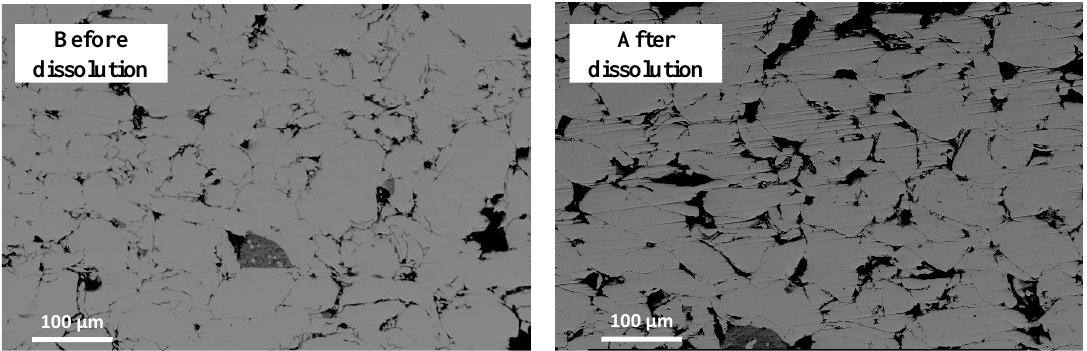
Figure 10. Scanning electron microscope (SEM) micrograph (mode BSE (back-scatter electron). of sintered pellet at 800 °C, before and after dissolution.